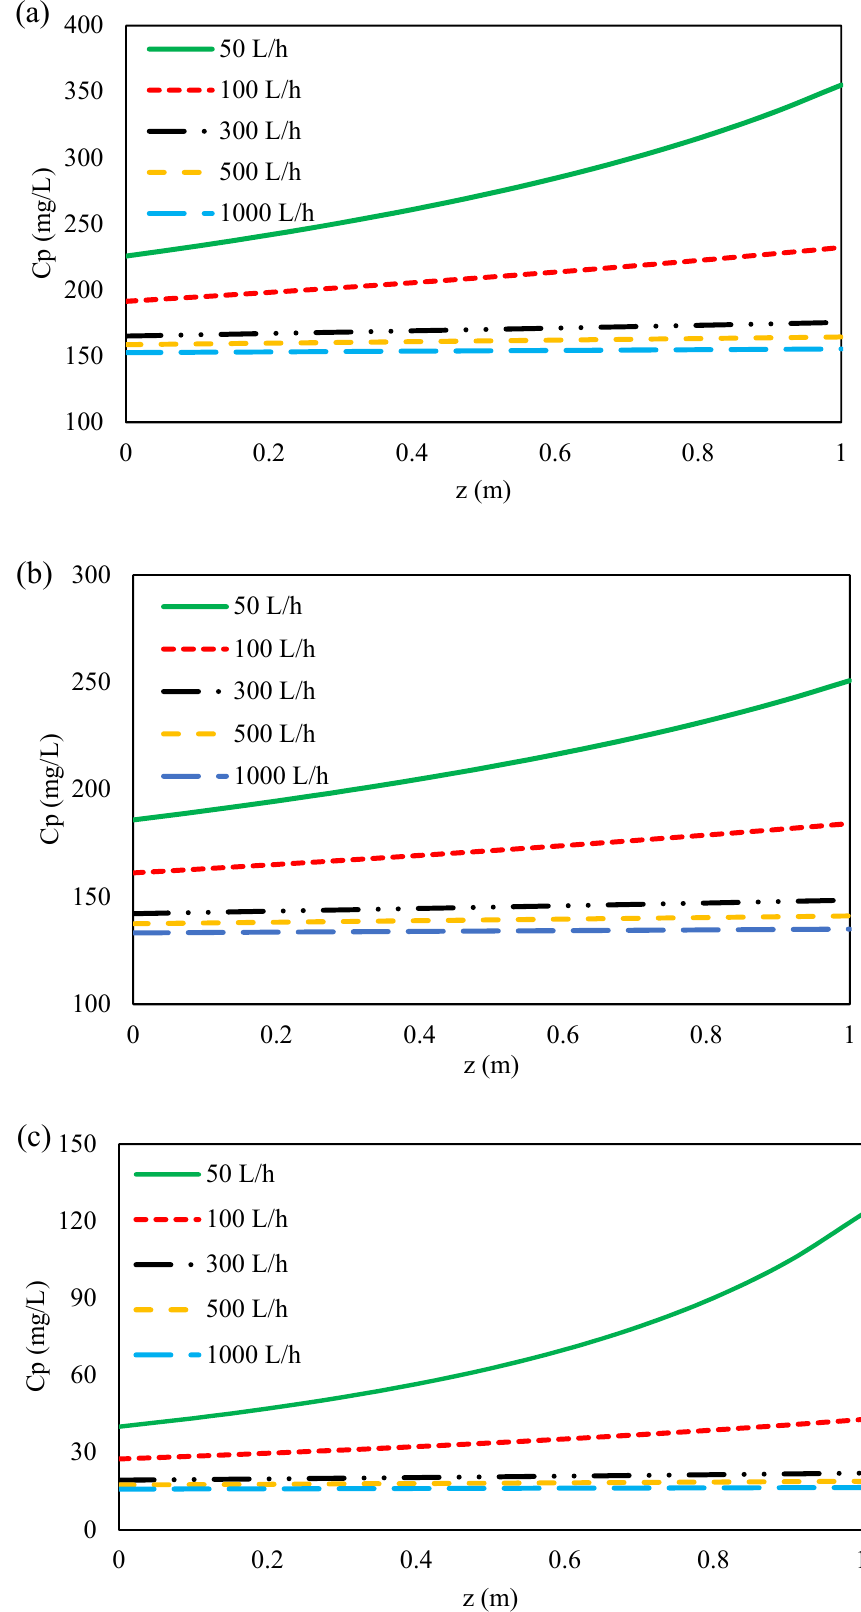
Figure 11. Permeate concentration variations along the feed flow direction for ( a ) formate, ( b ) acetate, ( c ) sulfate at different feed flow rates and 70 bar inlet feed pressure.